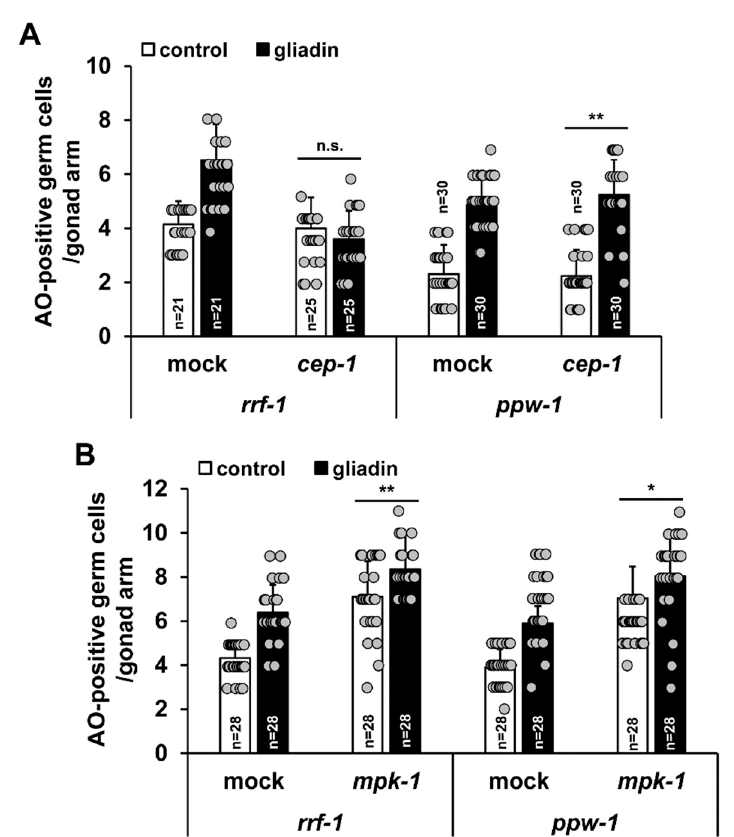
Figure 9. cep-1 and mpk-1 function in different tissues is required for increases in germ cell apoptosis triggered by gliadin intake. ( A,B ) After RNA interference (RNAi) treatment of control, cep-1, or mpk-1 worms at the L1 stage, worms were grown in nematode growth medium (NGM) plates and treated with or without gliadin for starting at the L4 stage for 24 h. Acridine orange (AO)-positive germ cells were observed in either RNAi-treated rrf-1 or ppw-1 mutant backgrounds 24 h after gliadin treatment. n.s., not significant. * p < 0.05. ** p < 0.005 (Student’s t -test).